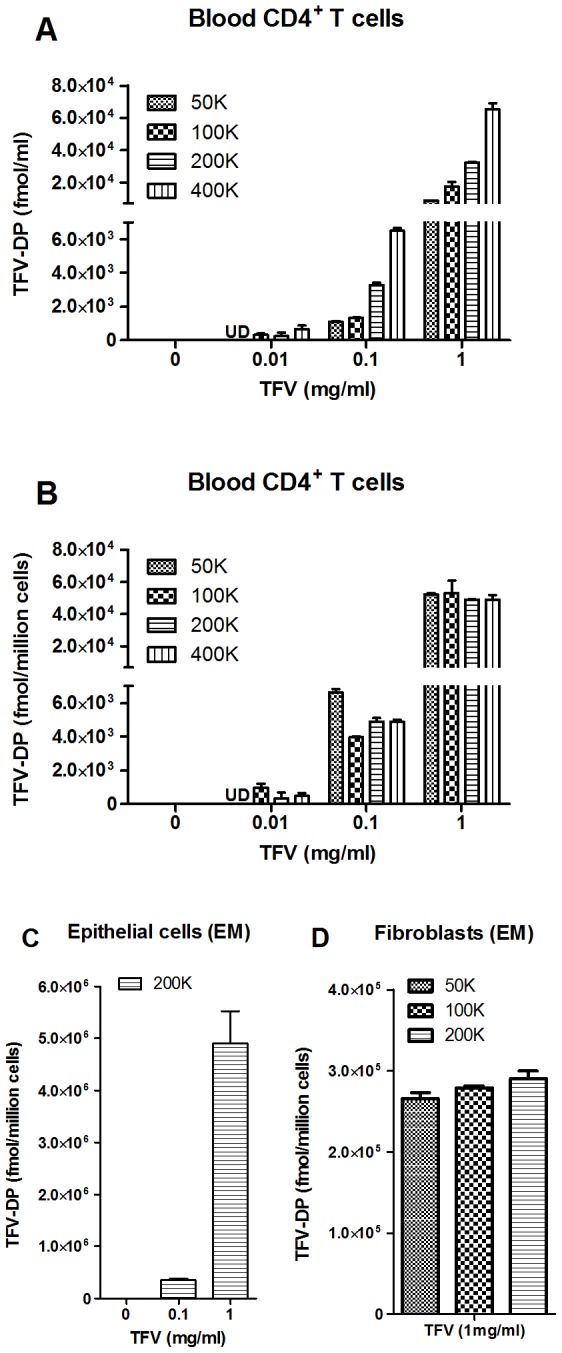
Blood CD4+ T cells and endometrial epithelial cells and fibroblasts metabolize TFV to TFV-DP.TFV-DP levels were measured by LC-MS/MS in increasing numbers of purified blood CD4+ T cells (A and B) and EM epithelial cells (C) and fibroblasts (D) treated with indicated dose of TFV for 24 hr. Bars represent mean and SEM from triplicate cultures. Values are expressed as fmol per ml in (A) and fmol/million cells in (B, C and D).